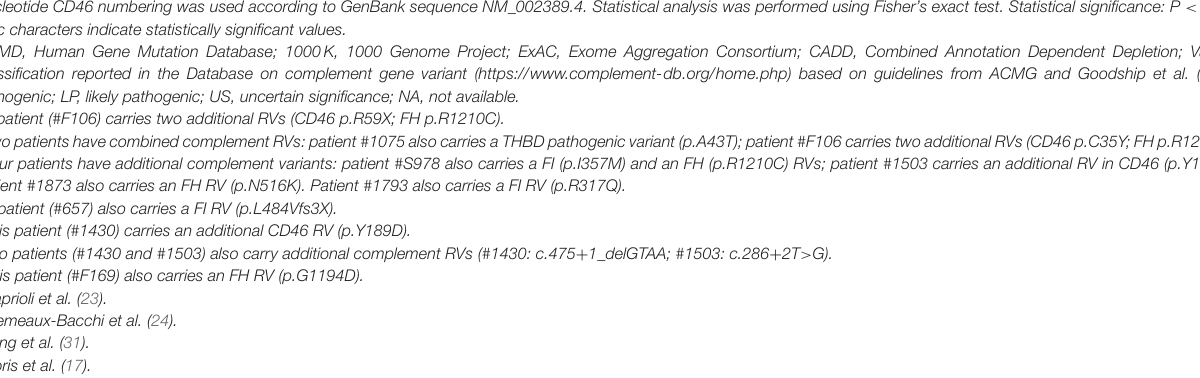
TABLE 1 | List of CD46 rare variants (RVs; variants with minor allele frequency < 0.001 in 1000 Genomes and ExAC databases and with CADD phred score ≥ 10) identified in 485 atypical hemolytic uremic syndrome (aHUS) patients recruited through the International Registry of HUS/TTP. P - Exon CD46 rare variants Patients Ctrs ( n = 485) ( n = 319) value